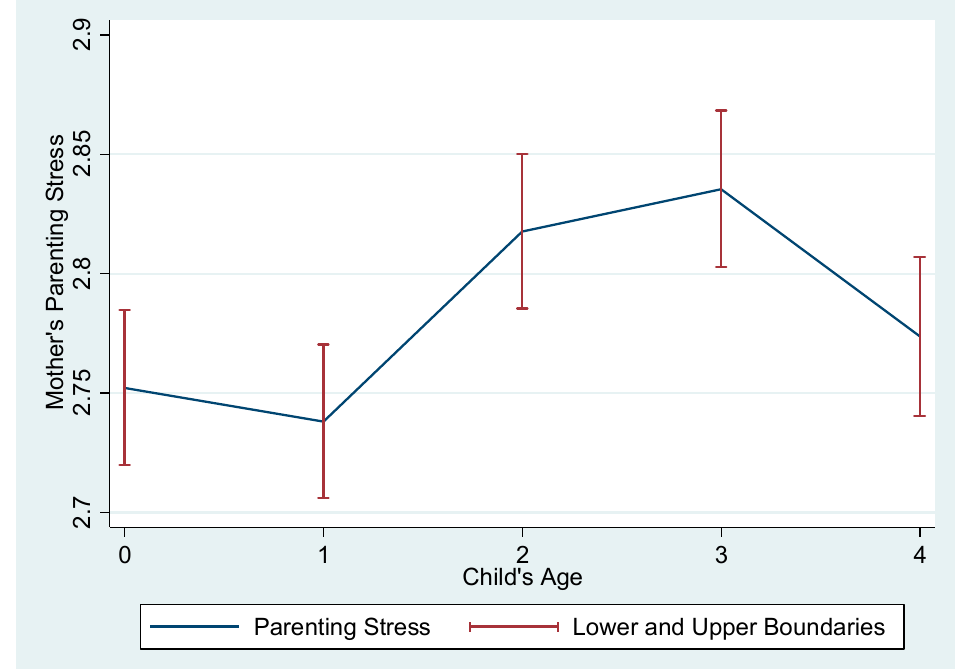
Figure 1. Trajectory of Mother’s Parenting Stress by Child’s Age.